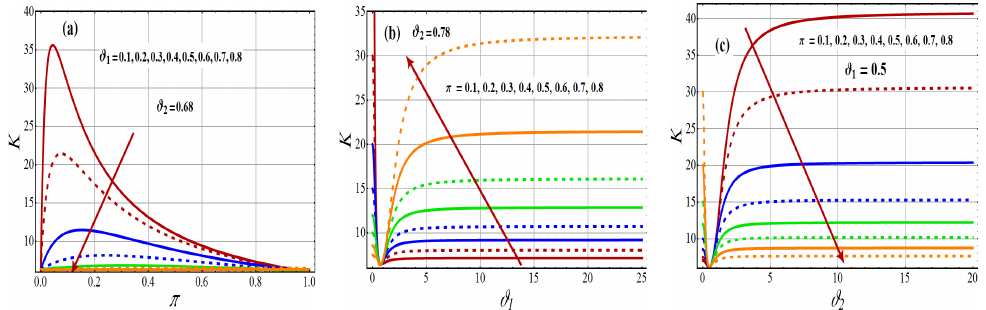
(cid:0) ˘ (cid:1) Fig. 6. Variations of Coe¢ cient of Kurtosis Figure 6. Variations of coefficient of kurtosis ψ K , for Figure 5 depict the graphs of the Skewness of one component distribution and 2-CMSM( (cid:21)(cid:1) ) for various parametric values. As noted in Figure 5, the Skewness of each component model grows, decreasing and constant whereas Skewness for 2-CMSM( (cid:21)(cid:1) ) increasing function under di⁄erent